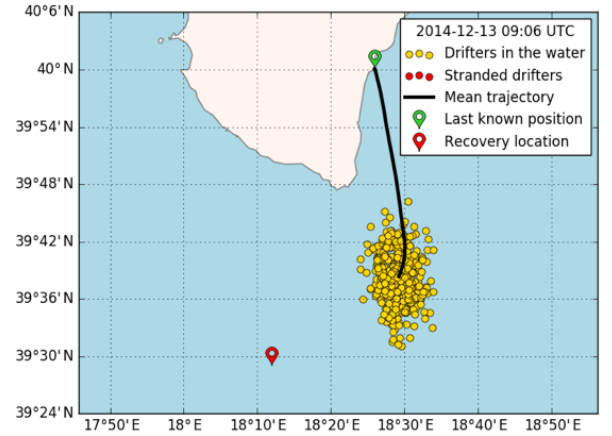
Figure 15. Results of the “ferry” simulation done using OCEAN- SAR showing the positions (yellow points) of the particles at the end of the simulation 10:30UTC on 7 December 2012. The red place marker indicates the position at which the person was found at sea after 14h from the last time he was seen on board of the ferry. The green segments represent the route of the ferry along which the particles have been